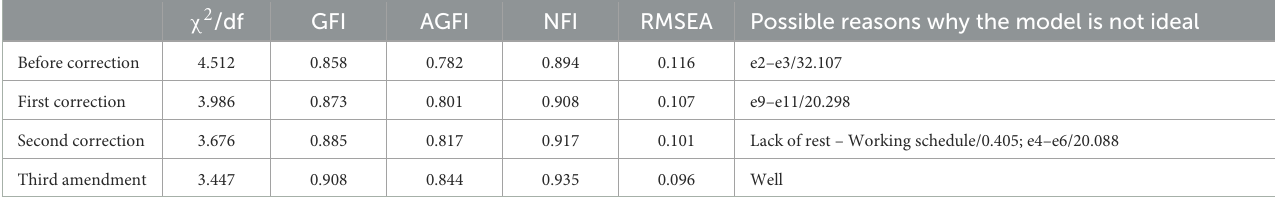
TABLE 7 Path analysis of various influencing factors of fatigue in the “work” dimension of long-haul flight pilots and the statistics of each adaptation index of the revised results.